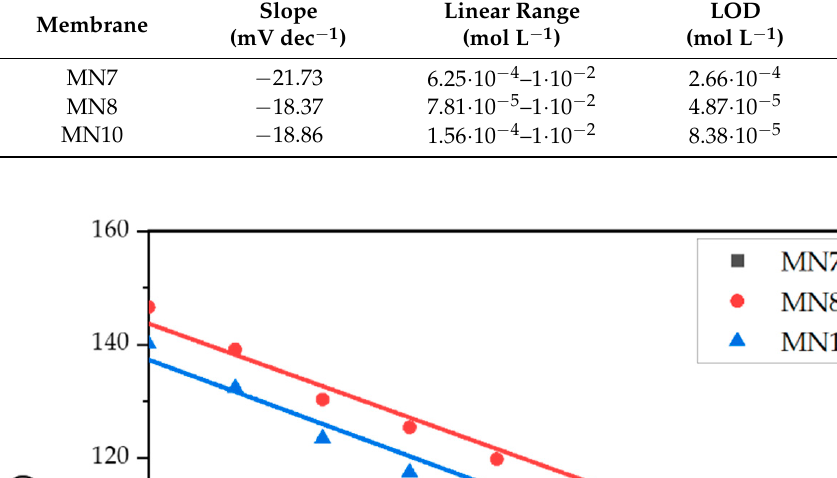
Table 4. Test results using membranes modified with boehmite and alumina NPs. Membrane